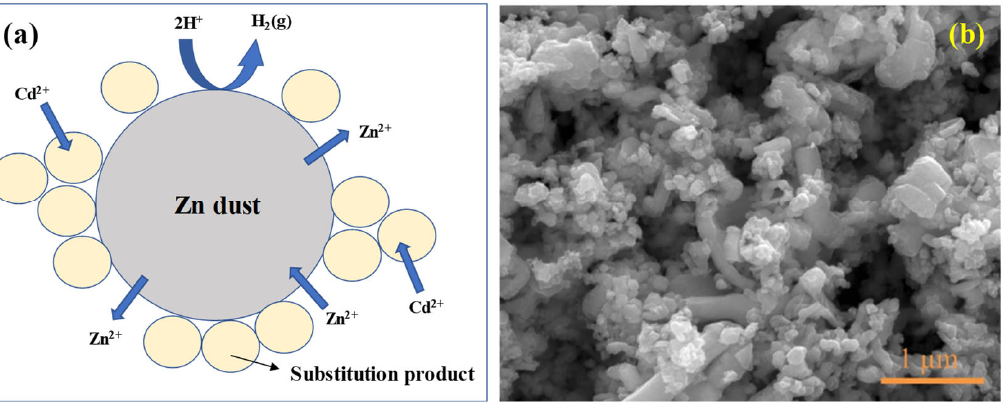
Figure 7. ( a ) Principle of the Zn cementation method; ( b ) SEM image of sponge Cd after metallic Zn cementation, reproduced from [83], with permission from Elsevier, 2022.